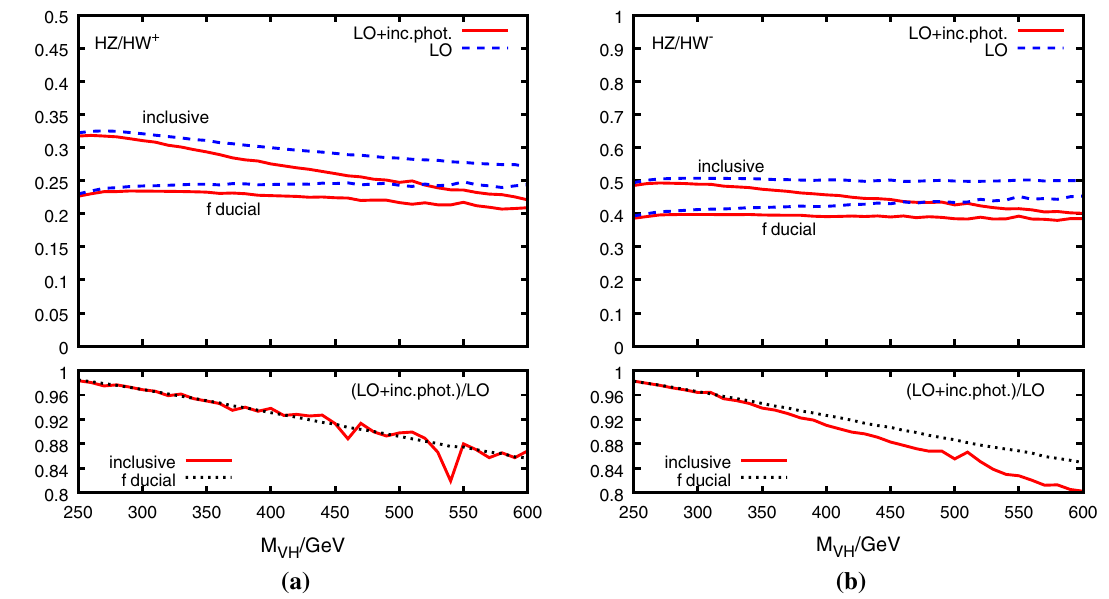
Fig. 6 Same as Fig.5, but for photon-induced corrections σ γ , i.e. γ q → qVH , and using LUXqed_plus_PDF4LHC15 PDFs with α s ( M Z ) = 0 . 118[26,33]